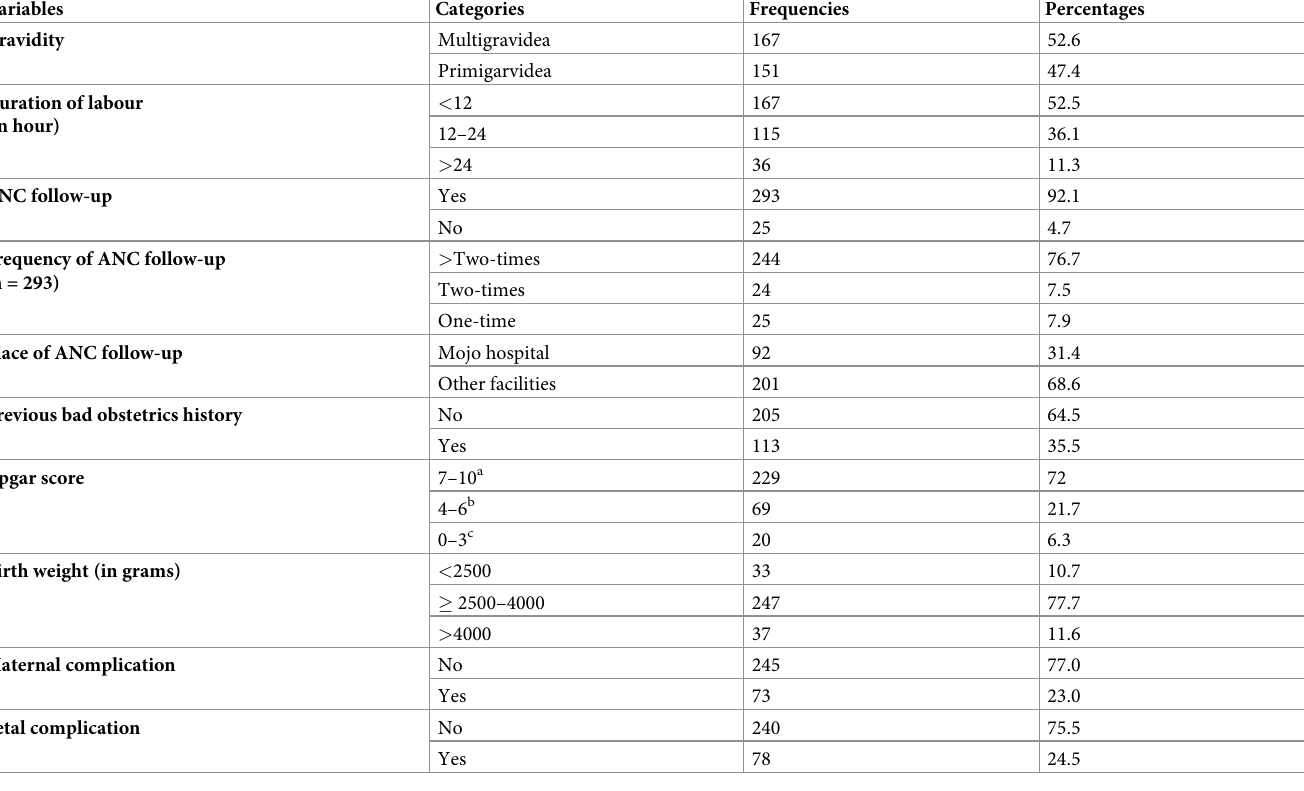
Table 2. Obstetric characteristics and labour outcomes of women who gave birth at public health facilities in Mojo town, Central Ethiopia, 2019 (n = 318). Variables